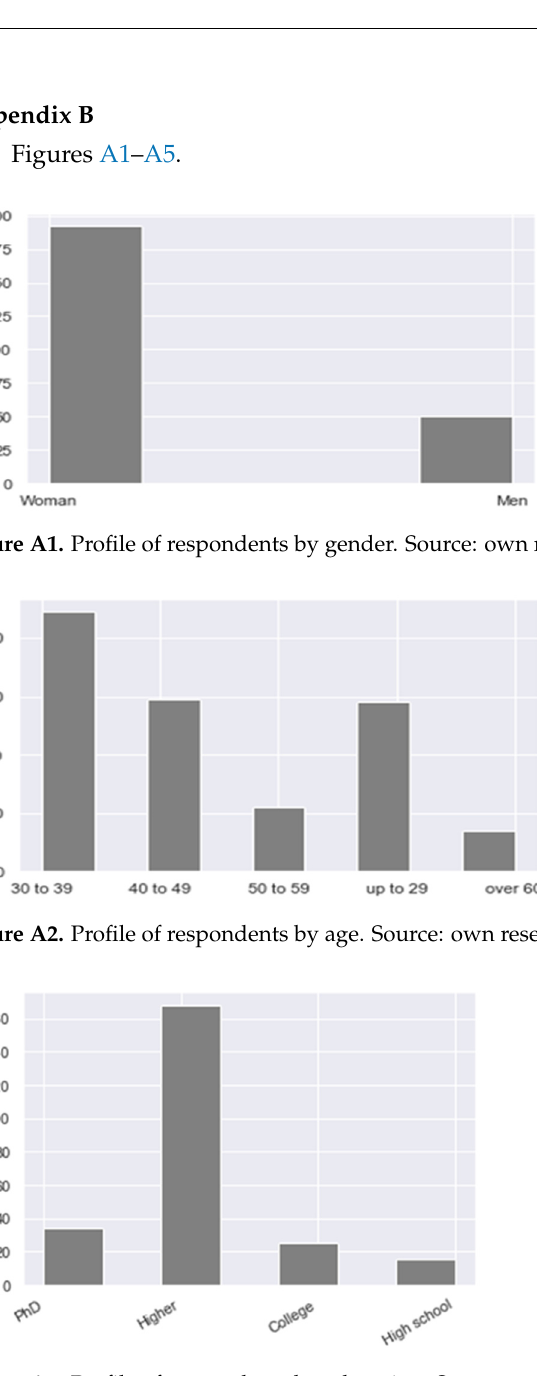
Figure A3. Profile of respondents by education. Source: own research.